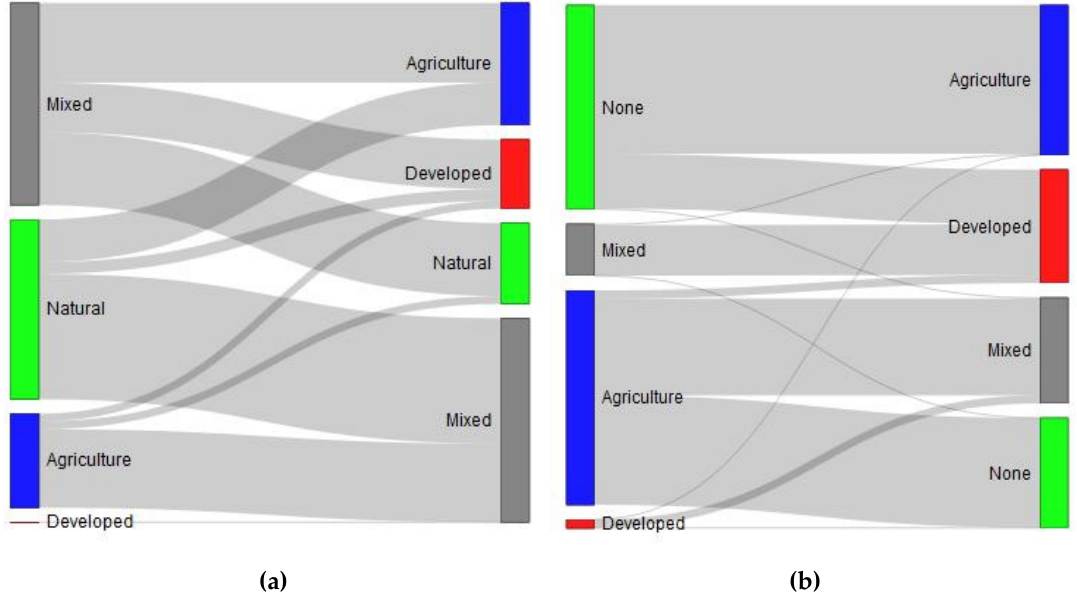
Figure 4. Flow diagrams of CONUS land area change among ( a ) dominance classes and ( b ) interface classes. The total of dominance class change was 172,006 km 2 , and the total of interface class change was 152,602 km 2 . Within each diagram, flow is from 2001 (left) to 2016 (right). Flows less than 5 km 2 are not shown. Excludes water area. Interactive versions of the flow diagrams are contained in Supplemental material.